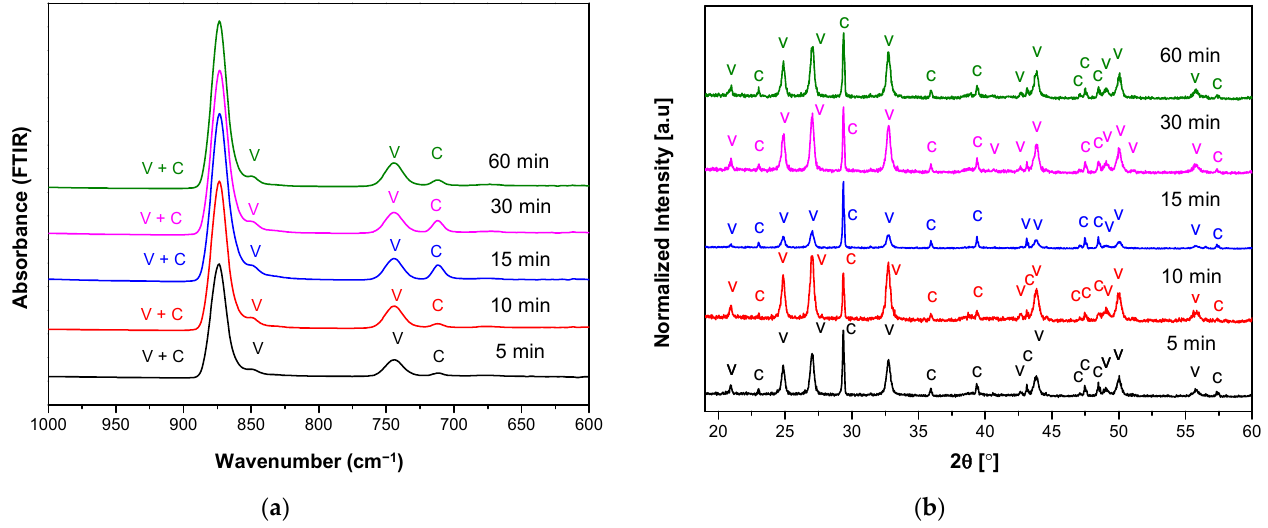
Figure 3. ( a ) FTIR and ( b ) XRD spectra of vaterite synthesized at 20 °C for different reaction times (5–60 min) at stirring speed 1000 rpm. Polymorphs main peak is indicated (V = vaterite, C = calcite).